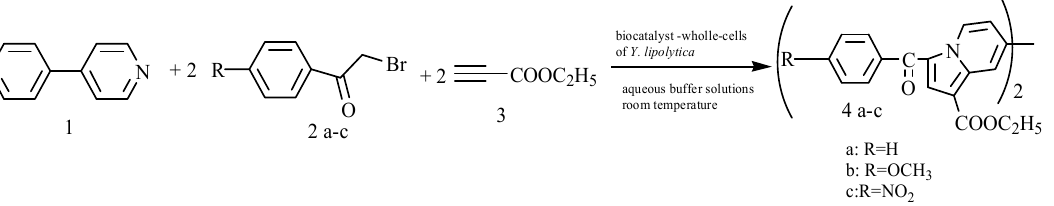
Figure 1. Indolizine synthesis in one-pot bioformation reactions using Yarrowia lipolyti ca crude